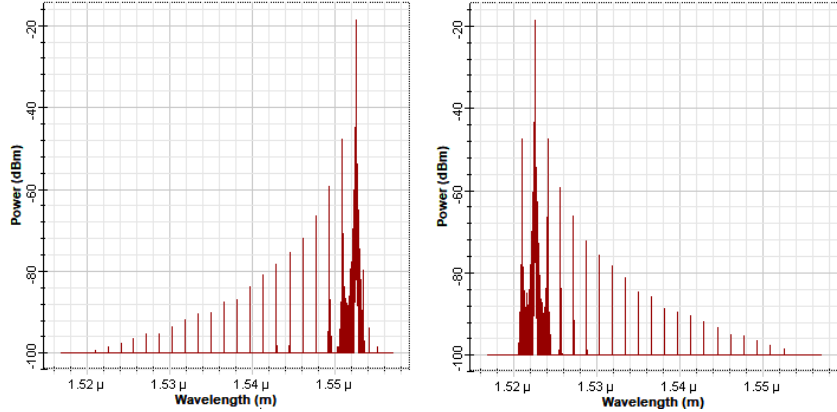
Figure 10. Optical spectrums for the first and twentieth channels SOA.